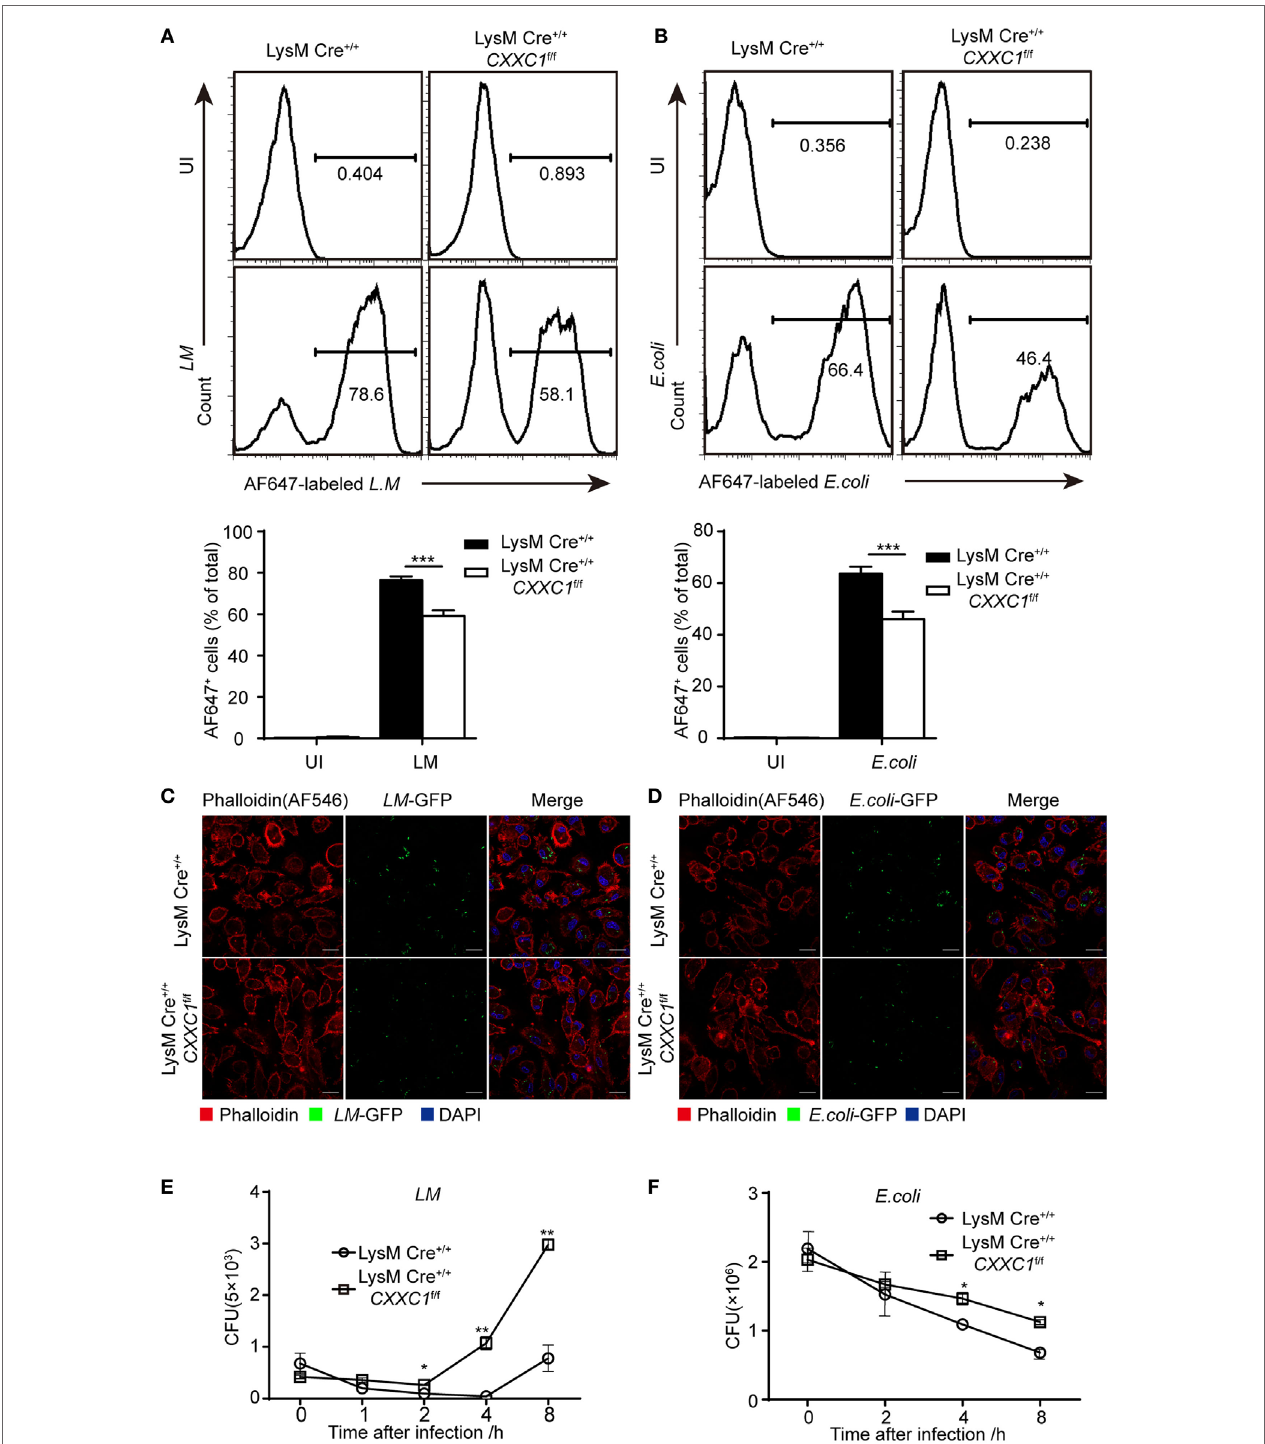
FigUre 1 | Compared with macrophages from wild-type mice, Cxxc finger protein 1 (CFP1)-deficient macrophages showed defective phagocytosis and intracellular killing of bacteria. (a,B) Flow cytometry of wild-type (black rectangle) and CFP1-deficient macrophages (white rectangle) left uninfected (UI) or infected for 60 min with either AF647-labeled Listeria monocytogenes (AF647- LM ) at a multiplicity of infection (MOI) of 10 (a) or with AF647-labeled E. coli (AF647- E. coli ) at an MOI of 20 (B) . (c,D) Confocal microscopy images of GM-CSF-derived CFP1-deficient macrophages and wild-type cells incubated with L.M -GFP (MOI, 10) (c) or E. coli -GFP (MOI, 20) (D) . The scale bars represent 20 µm. (e,F) Pathogen burden in wild-type (white circle) and CFP1-deficient (white square) macrophages infected with L. monocytogenes (MOI, 1) or E. coli (MOI, 20), presented as colony-forming units (CFU). The mean and SD of four independent experiments are shown. * P < 0.05, ** P < 0.01 and *** P < 0.001 indicate significant differences between groups as determined by Student’s t -test.